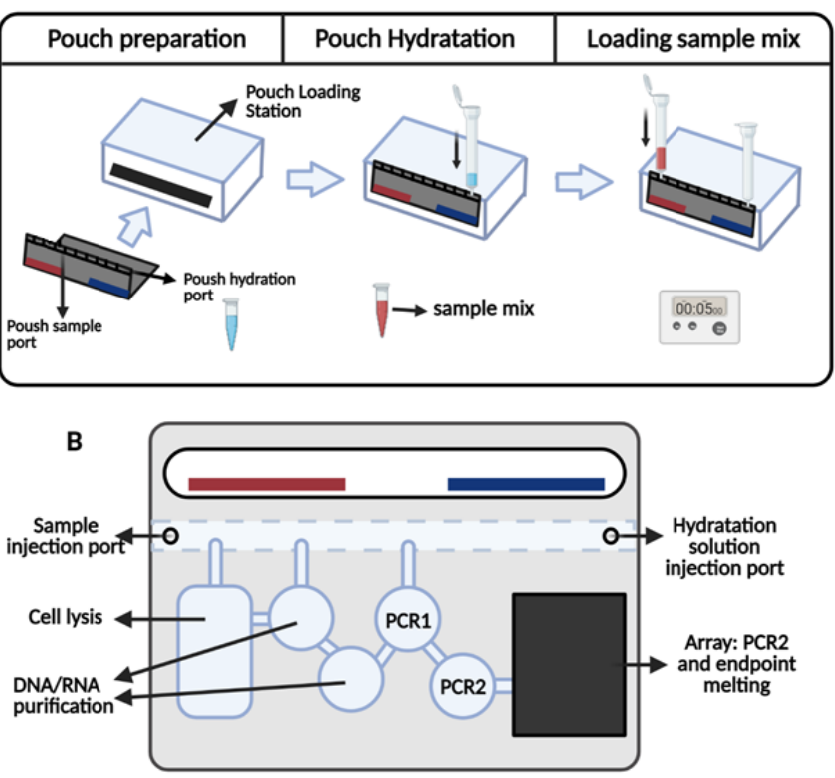
Figure 1. ( A ) Schematic view of the BioFire ® COVID-19 Test quick workflow including the insertion of the pouch into Pouch Loading Station with sample vial and hydration injection vial, pushing down to puncture seal and hydrating the solution, adding specimen to the sample injection vial, loading sample mix into the pouch in 5 s, discarding the vials, followed by inserting the pouch into the system and running the test. ( B ) Schematic view of FilmArray ® system. After sample injection, the system lyses the sample by agitation, extracts and then purifies NA using magnetic bead technology and Performs nested multiplex PCR: PCR1 a reverse transcription multiplexed reaction, PCR2 multiple singleplex second-stage PCR reactions amplifying PCR1 products.